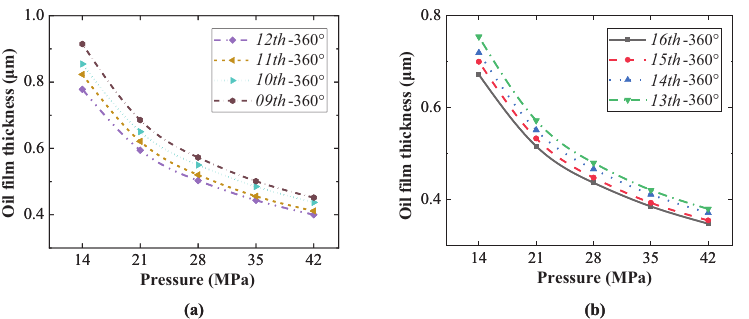
Figure 21. Variation in oil film thickness with pressure. ( a ) 9th ∼ 12th circles. ( b ) 13th ∼ 16th